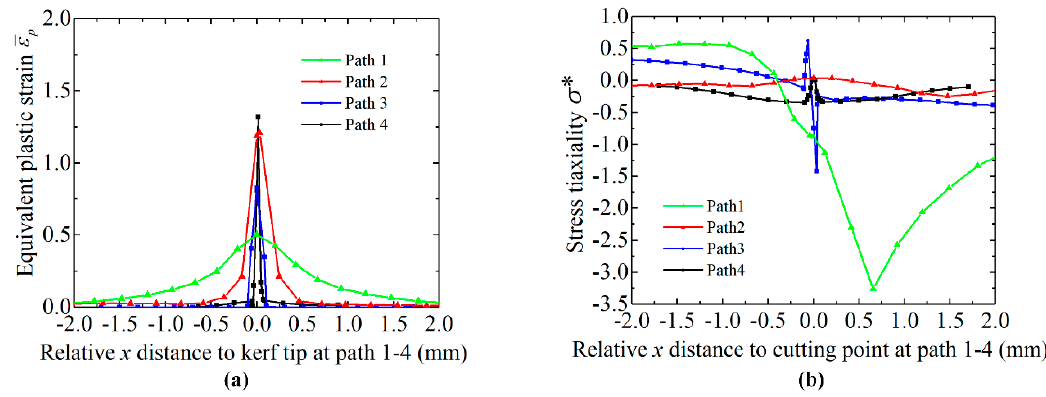
Figure 7. Equivalent plastic strain ε p and stress triaxiality σ ∗ along with path 14. ( a ) ε p . ( b ) σ ∗ .